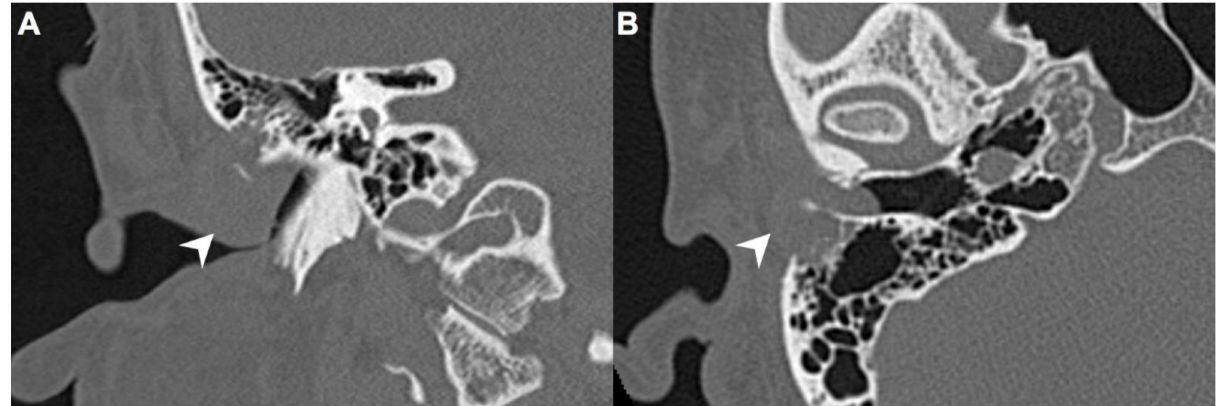
Figure 2. ( A ) On high-resolution computed tomography (HRCT), right EAC was occupied by a mass (arrow) on coronal view. ( B ) This submucosal soft tissue mass (arrow) was accompanied by partial mastoid bony destruction on axial